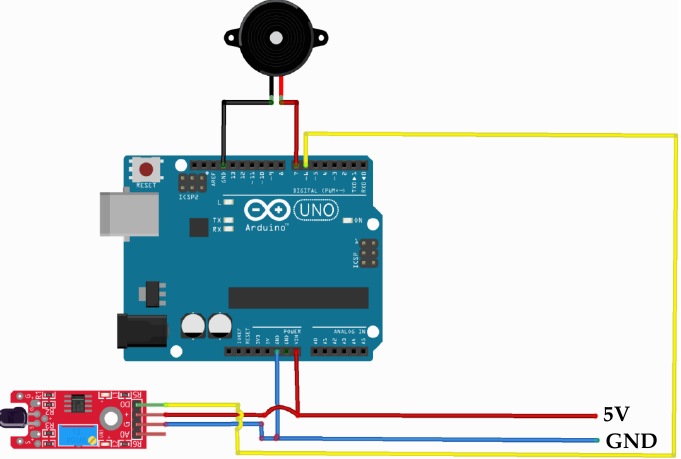
Figure 11. The control circuit for the fire alarm system in the smart home.